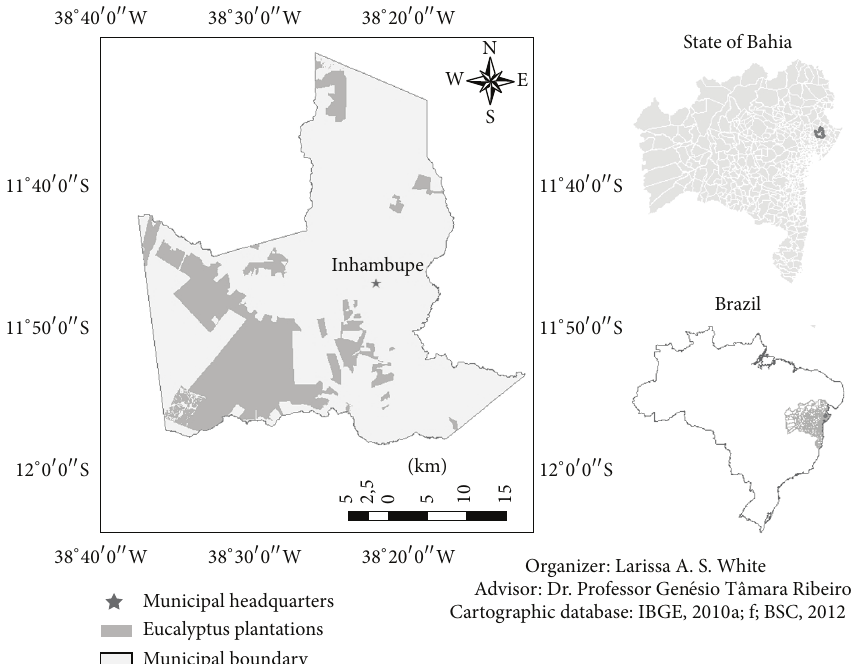
Figure 1: Focused area including the eucalypt plantations of the Bahia Specialty Cellulose